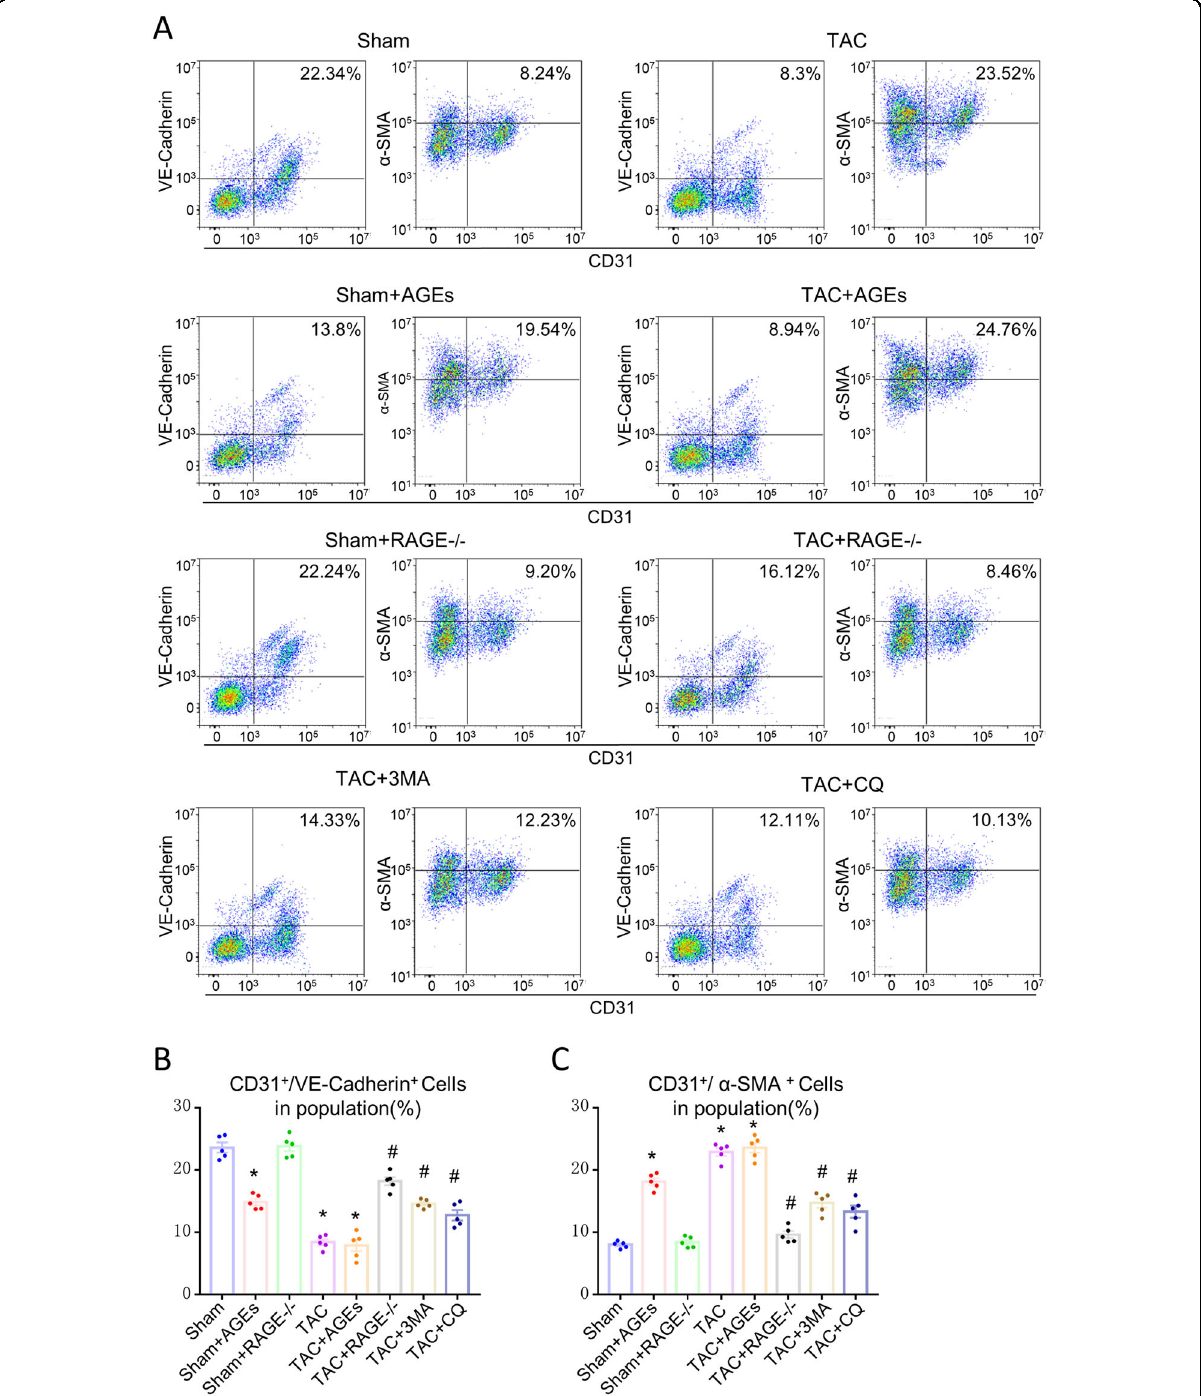
Fig. 4 EndMT is one origin of myo fi broblasts in HF and could be regulated by AGEs/RAGE and autophagy. A Flow cytometry analysis of primary isolates of mouse left ventricular cells. After mechanical disaggregation and enzymatic digestion, single-cell suspensions were incubated with combination of fl uorescent antibodies to CD31, VE-Cadherin, and α -SMA. B , C Quanti fi cation of co-expressed cell analysis. n = 5. Data are presented as mean ± SEM. * p < 0.05 vs. sham group, # p < 0.05 vs. TAC